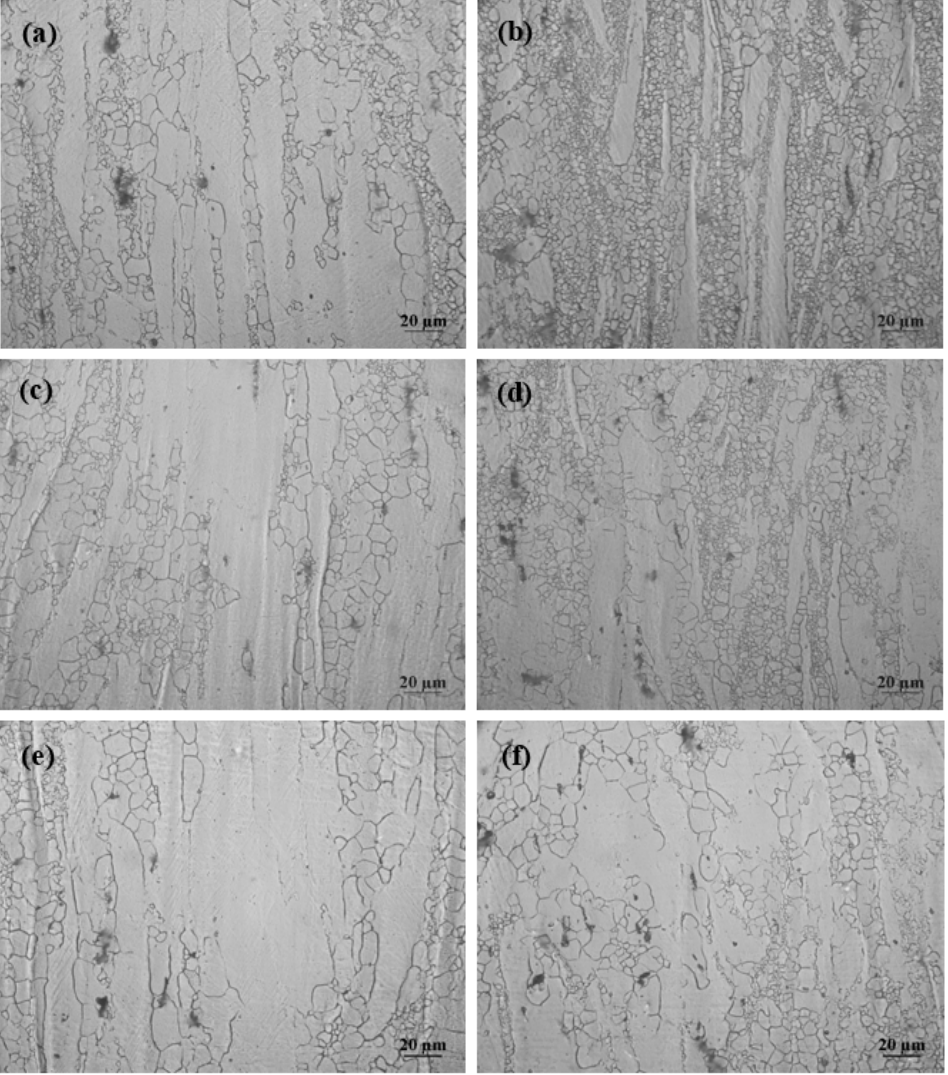
Figure 2. Microstructures of AZ31 alloy ( a , c , e ) and AZ31-1%CaO alloy ( b , d , f ) at a extrusion ratio of 6 under different extrusion temperatures: ( a , b ) 300 °C; ( c , d ) 350 °C; and, ( e , f ) 400 °C.